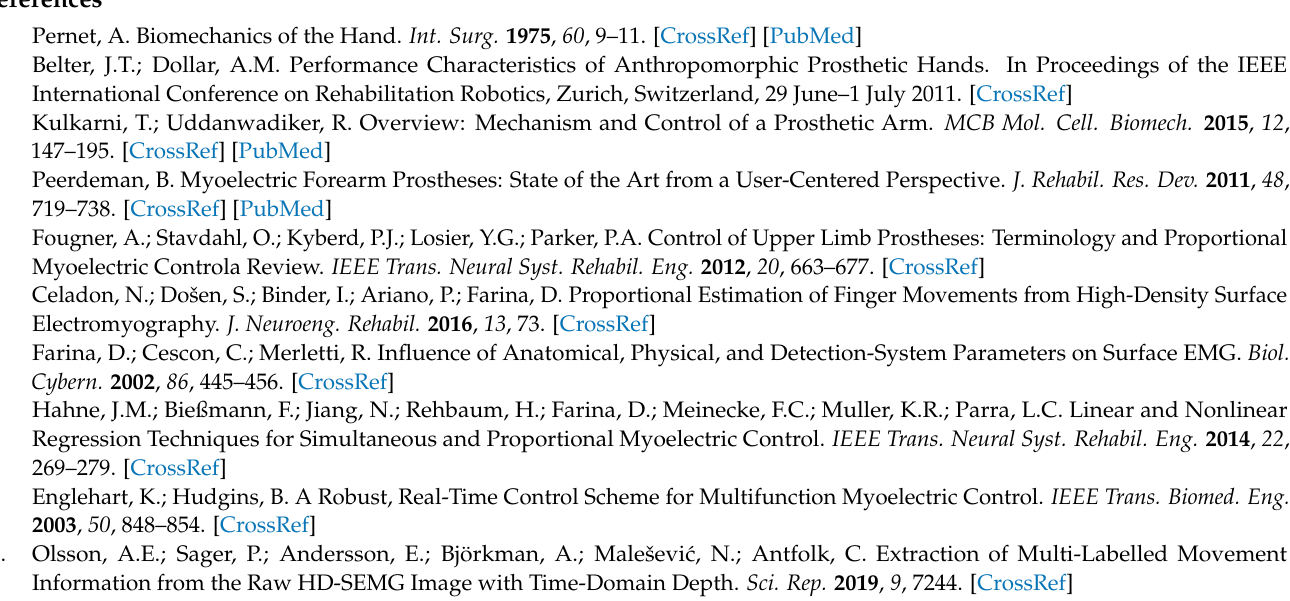
Figure A11. RMSE ( left ) and cross-correlation ( right ) for WA with different thresholds (Q multipliers of MAV at rest) and window widths (actual value of Q is shown/10).